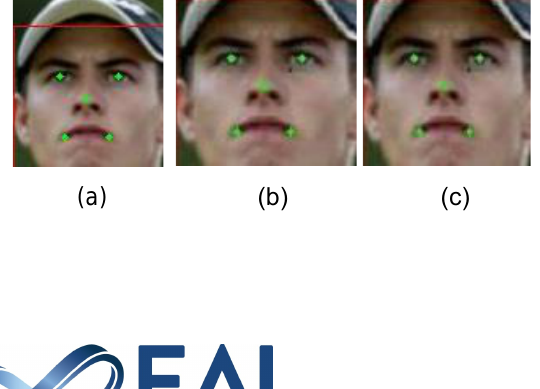
Figure 5. Adjusted network structure